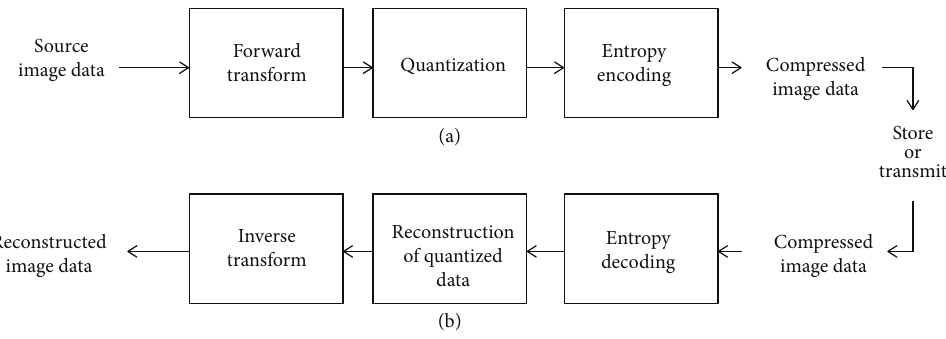
Figure 1: A general block diagram of image compression systems: (a) encoder and (b)